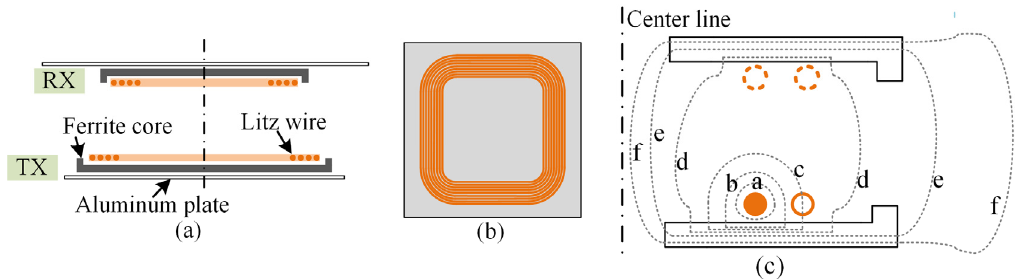
Figure 3. Overall design of the coil assemblies and the magnetic flux paths. ( a ) Front view. ( b ) Top view. ( c ) Magnetic flux paths.